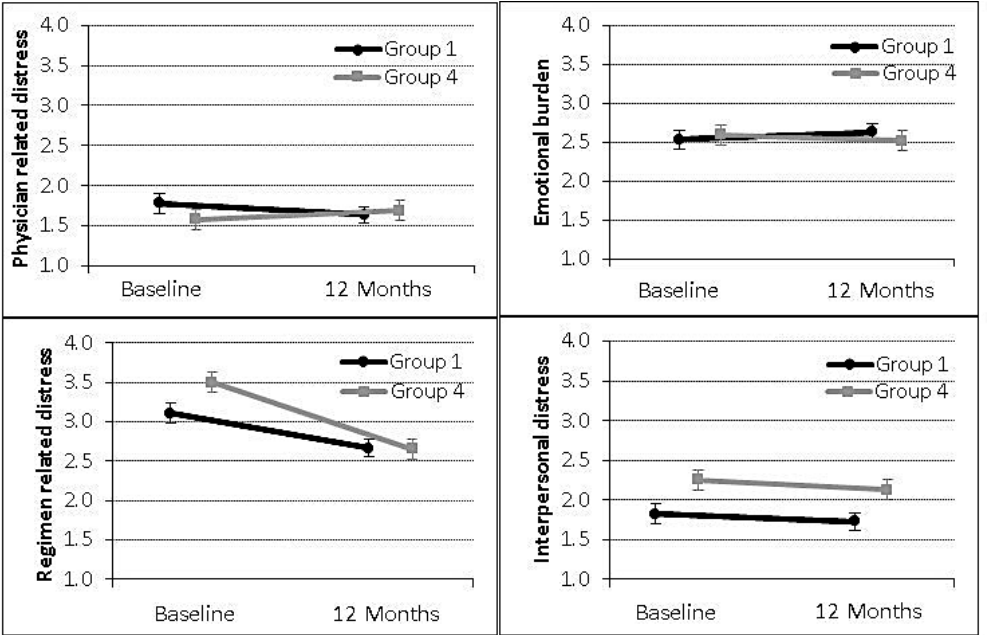
Figure 2. Mean and standard deviation for the change in Diabetes Distress Scale subscale scores from baseline to 12 months for control (n=46-56) and intervention (n=57-58) groups. Whiskers represent standard